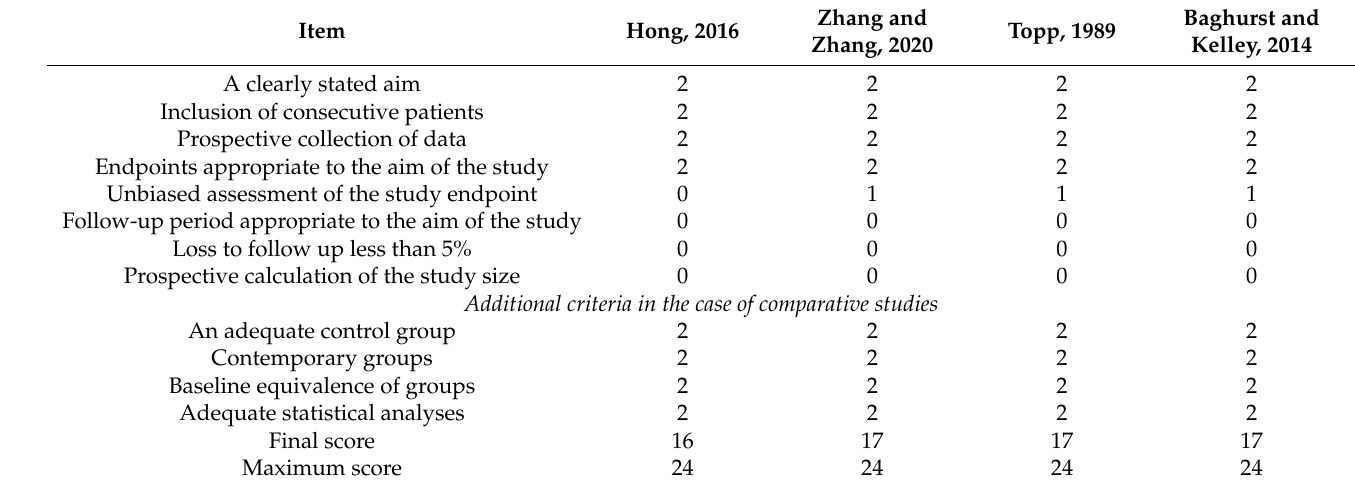
Table 3. Methodological Index for Non-randomized Studies (MINORS) scores for the included stud- ies [29–32].